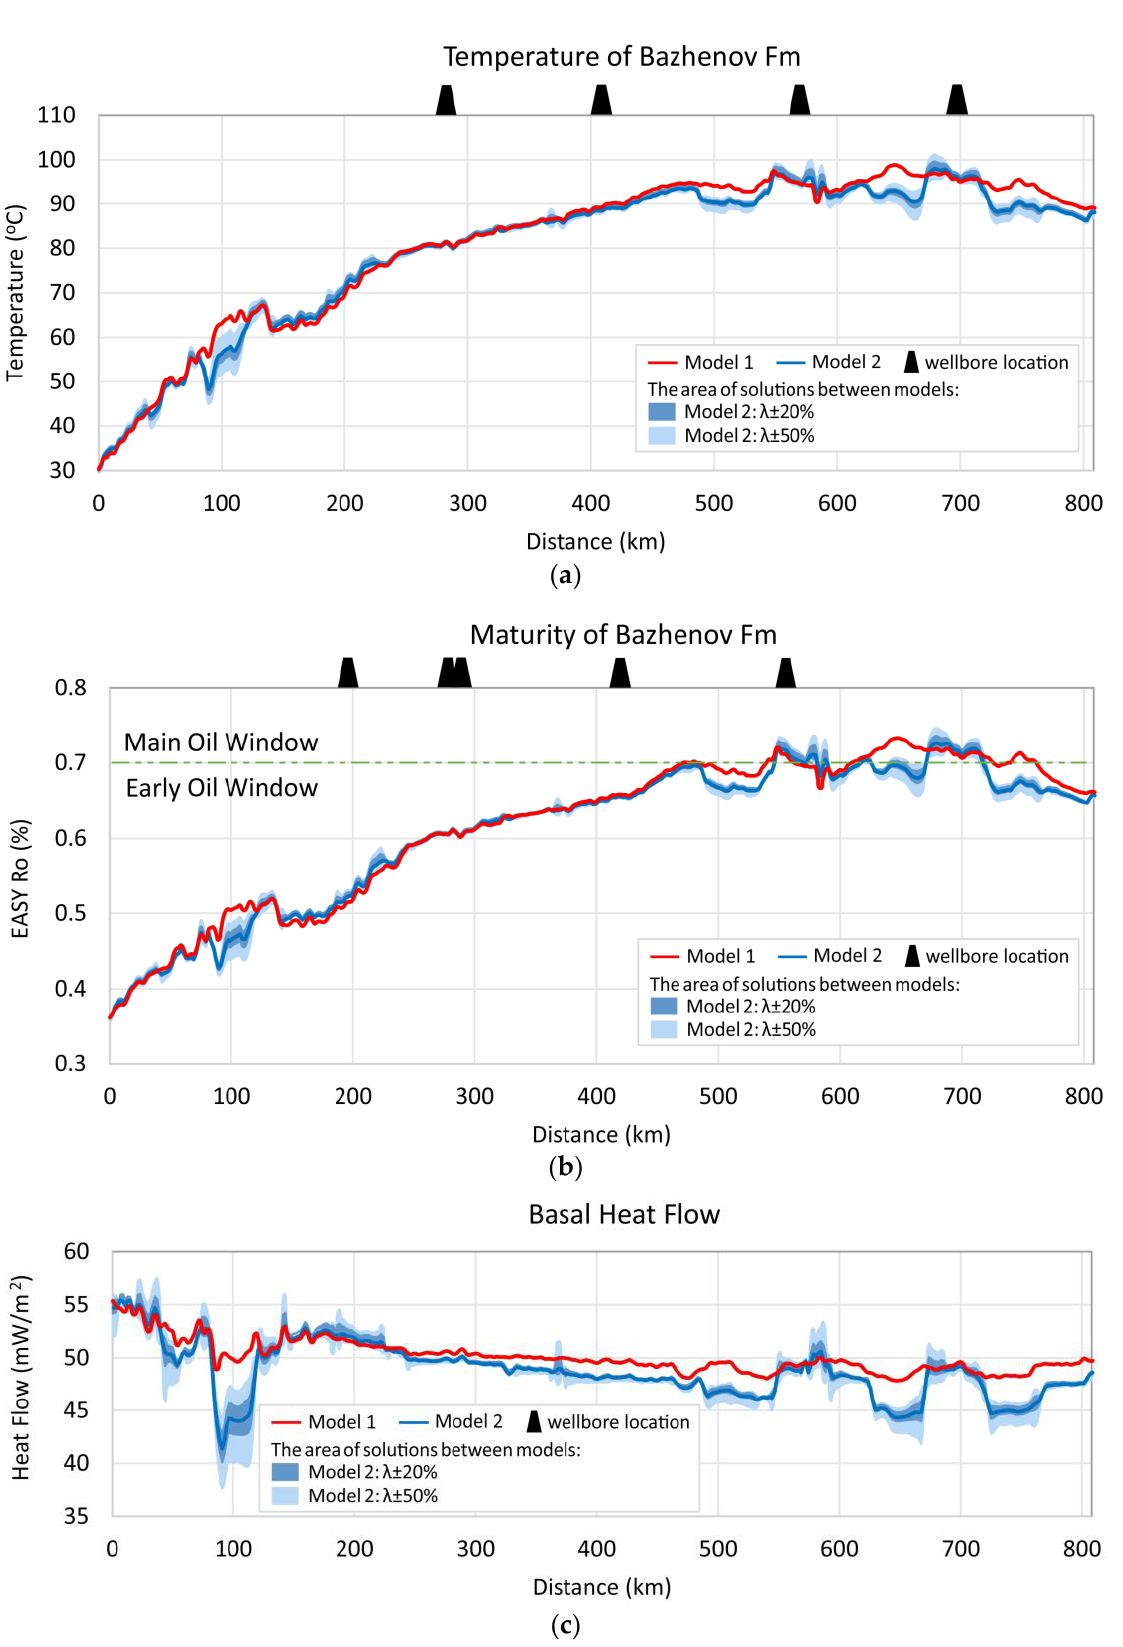
Figure 11. Calculated present-day ( a ) temperatures and ( b ) vitrinite reflectance by the EasyRo model [73] of the Ba-zhenov Fm surface and ( c ) basal heat flow for the investigated models.